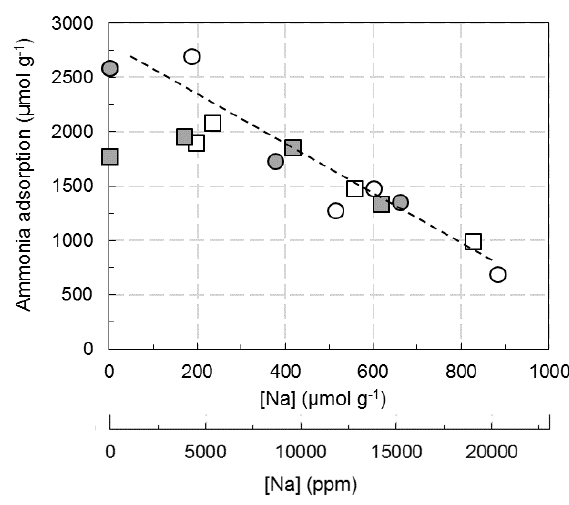
Figure 8. Relationship between the ammonia adsorption amount (determined by NH 3 adsorption evacuated at 50 °C) and the Na loading. : Cu 2.8 (W)/FER; : Cu 2.8 (Et)/FER; : Cu 6.1 (W)/FER; : Cu 6.1 (Et)/FER.